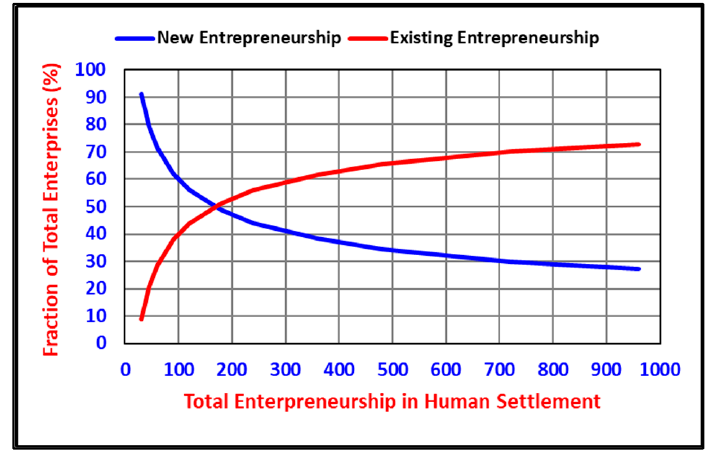
Figure 1. Levels of new and existing entrepreneurship as functions of the magnitude of the total entrepreneurship of a hypothetical human settlement. The hypothetical power law used is: New entrepreneurship = 0.3 (Total entrepreneurship) 0.65 . Percentage share of existing entrepreneurship = 100 minus percentage share of new entrepreneurship.